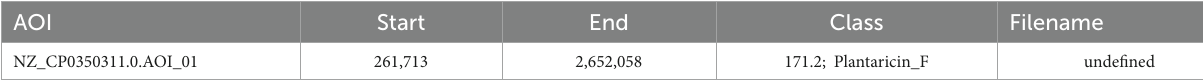
TABLE 3 The file name, class, and start and end.